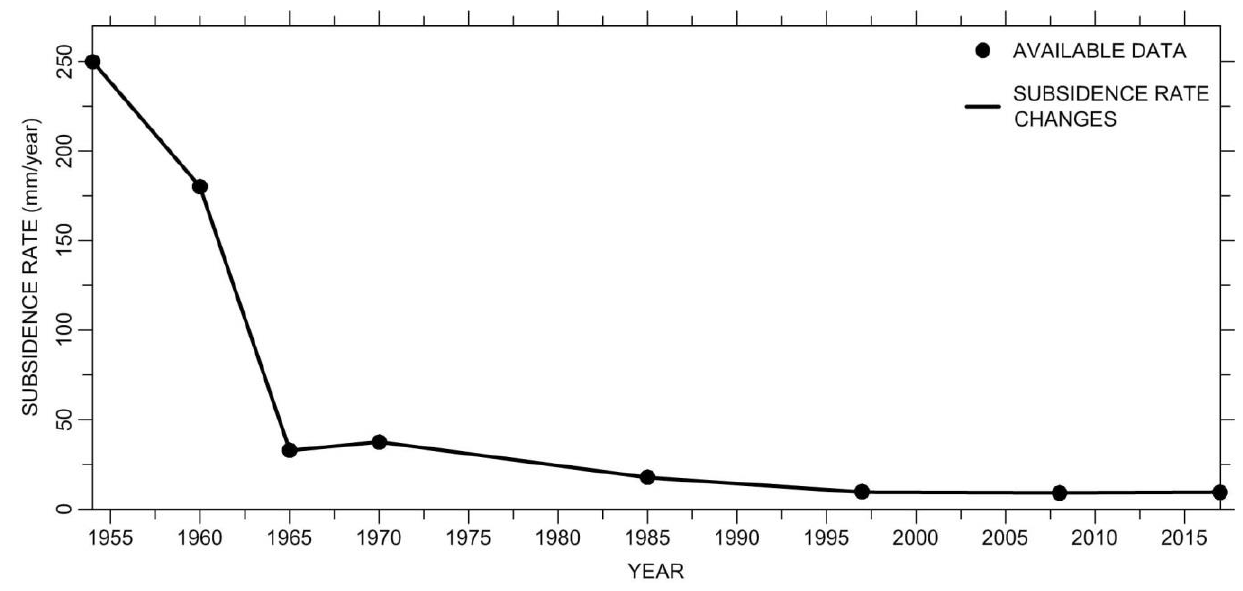
Figure 2. Subsidence rate changes from 1950 to 2017 based on the available data